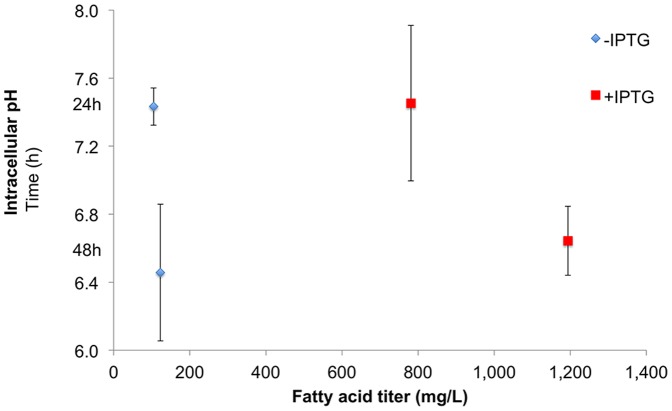
Production of carboxylic acids in strain ML103+pXZ18Z+pZS-GFP does not significantly change the intracellular pH.Shake flasks of E. coli producing predominately C14:0 and C16:0 carboxylic acids in M9 media with 1.5% dextrose at 30°C. IPTG induces the pXZ18Z plasmid carrying a thioesterase and a β-hydroxyacyl-ACP dehydratase. The intracellular pH values are the average of four biological replicates and four technical replicates. The error bars indicate the standard deviation.